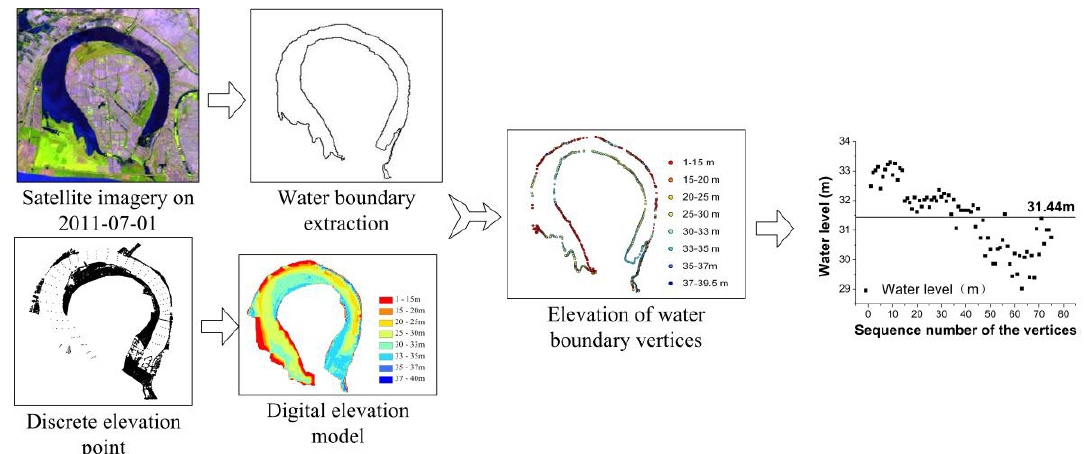
Figure 2. A flowchart of the water level data extraction in the oxbow lake on 1 July 2011, by using the WBET method (the average elevation of vertices on the water boundary is regarded as the water level on 1 July 2011, namely 31.44 m).